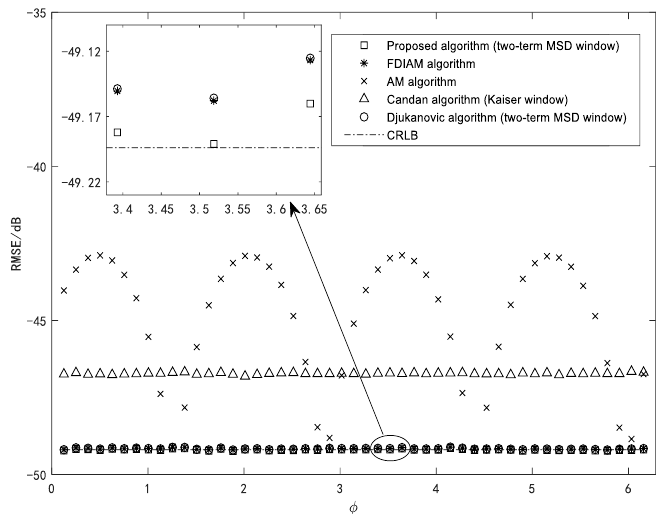
Figure 5. RMSEs versus φ for N = 128, f 0 = 0.1917, and SNR = 30